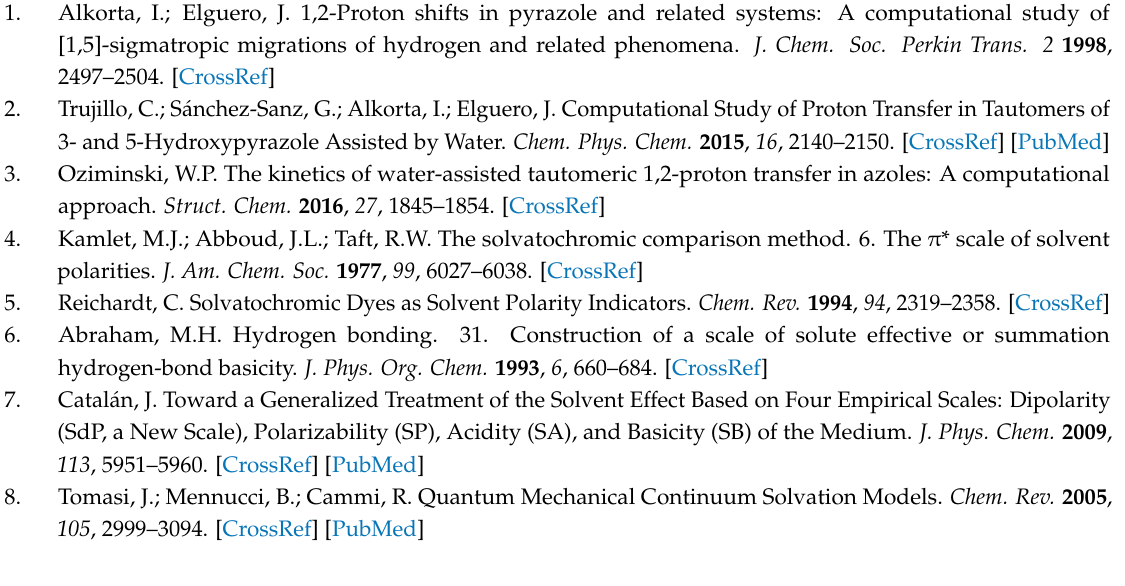
solvent, Figure S3: Evolution of the transition barriers vs. the complexes 1 , 2 , 3, and 4 , Figure S4: Evolution of the transition barriers vs. the number of guanidine substituent for complexes 1 , 3 , 5, and 6 , Table S1: Electron density properties (au) of the intermolecular BCP in the stationary points of the 1 + CO 2 energy profile, Table S2: Binding energies (kJ · mol − 1 ) and Linear relationship R 2 vs. 1/ ε of all the stationary points, Table S3: Interatomic distances (Å) in the stationary points, Table S4: Free Gibbs energies ( ∆ G ) obtained with respect to the entrance channel (isolated monomers) and with respect to the complex